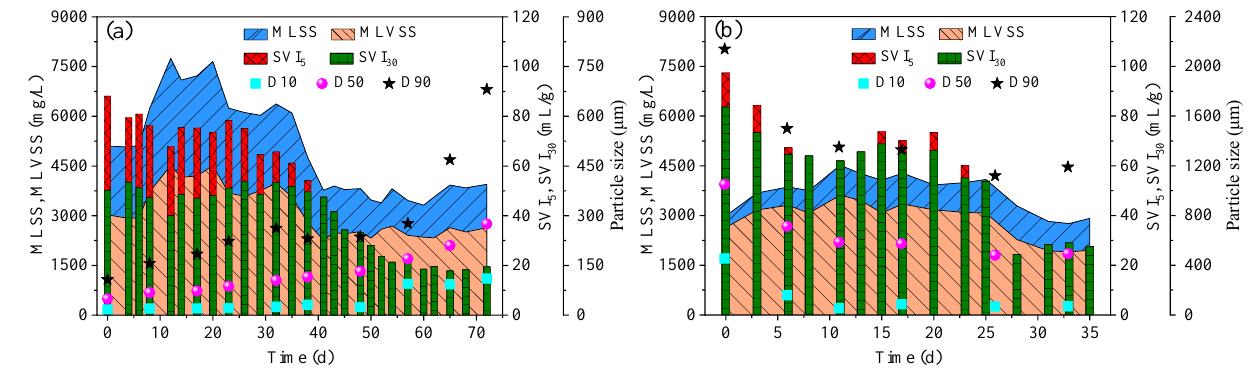
Figure 1. Variations in MLSS, MLVSS, SVI 5 , SVI 30 , and sludge particle size in R1 ( a ) and R2 ( b ) throughout the operational period.